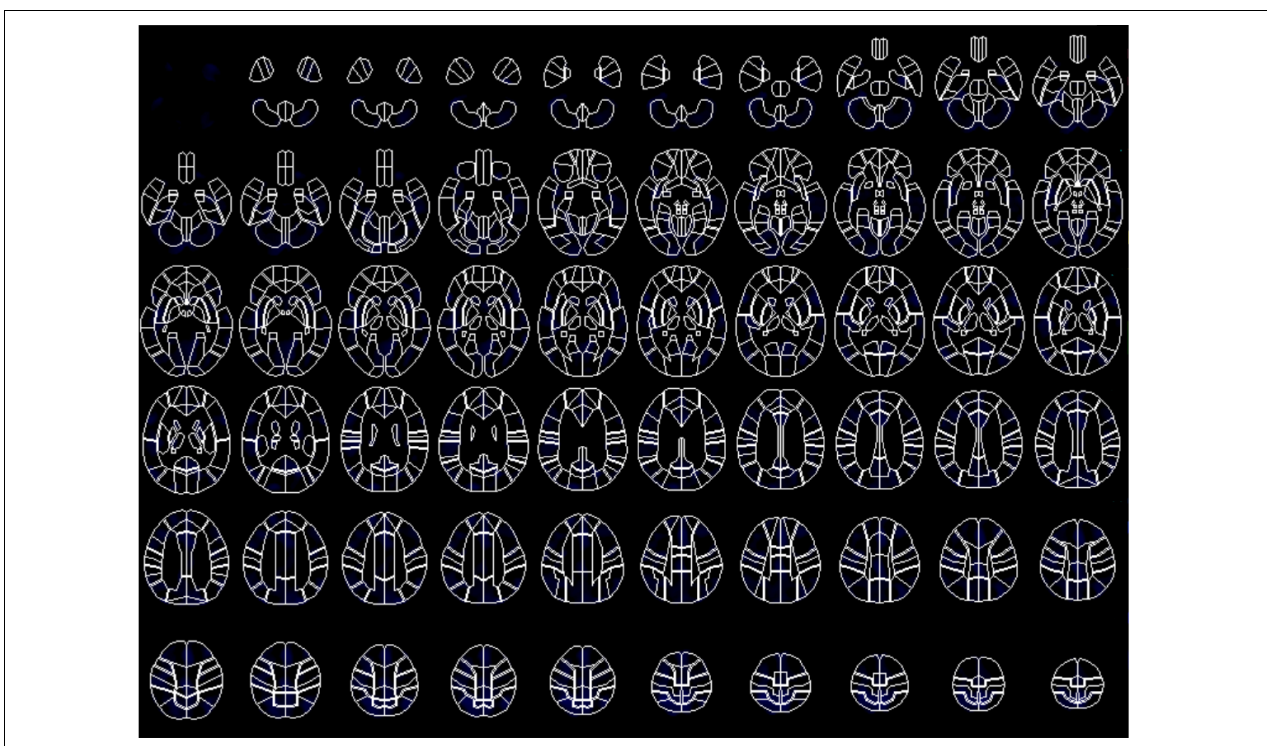
FIGURE 2 | Fine stereotactic region of interest (ROI) template (SRT) image composed of 52 areas of ROI in Single Photon Emission Computed Tomography (SPECT) study.